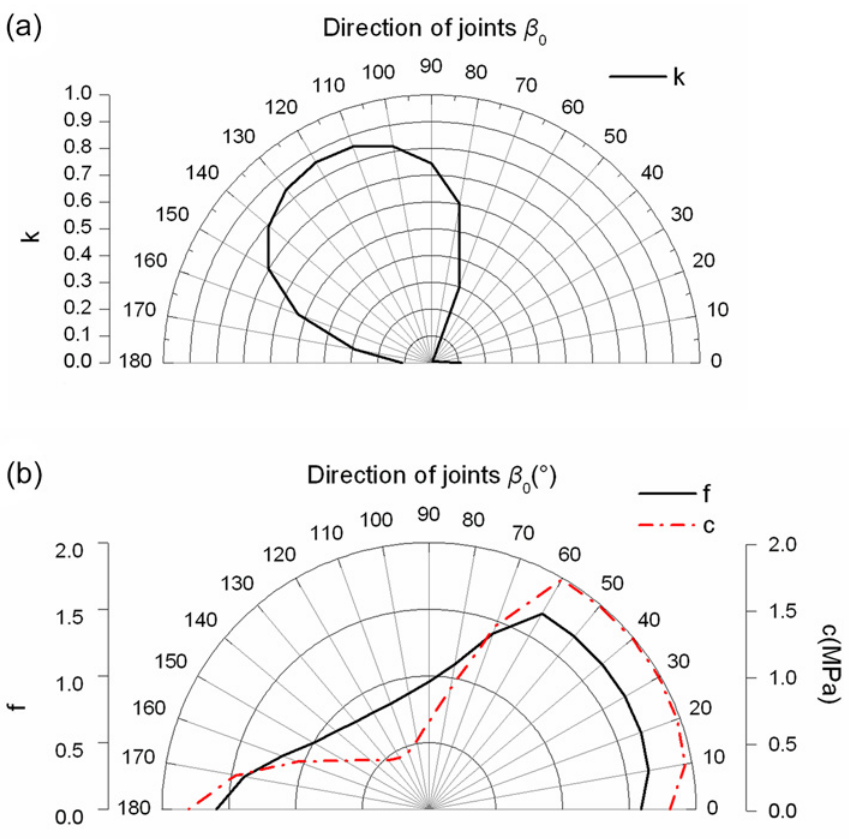
Fig 5. The rose diagrams of the persistence ratio, friction coefficient and cohesion((a) The rose diagrams of the persistence ratio of jointed rock mass; (b) The rose diagrams of friction coefficient and cohesion of jointed rock